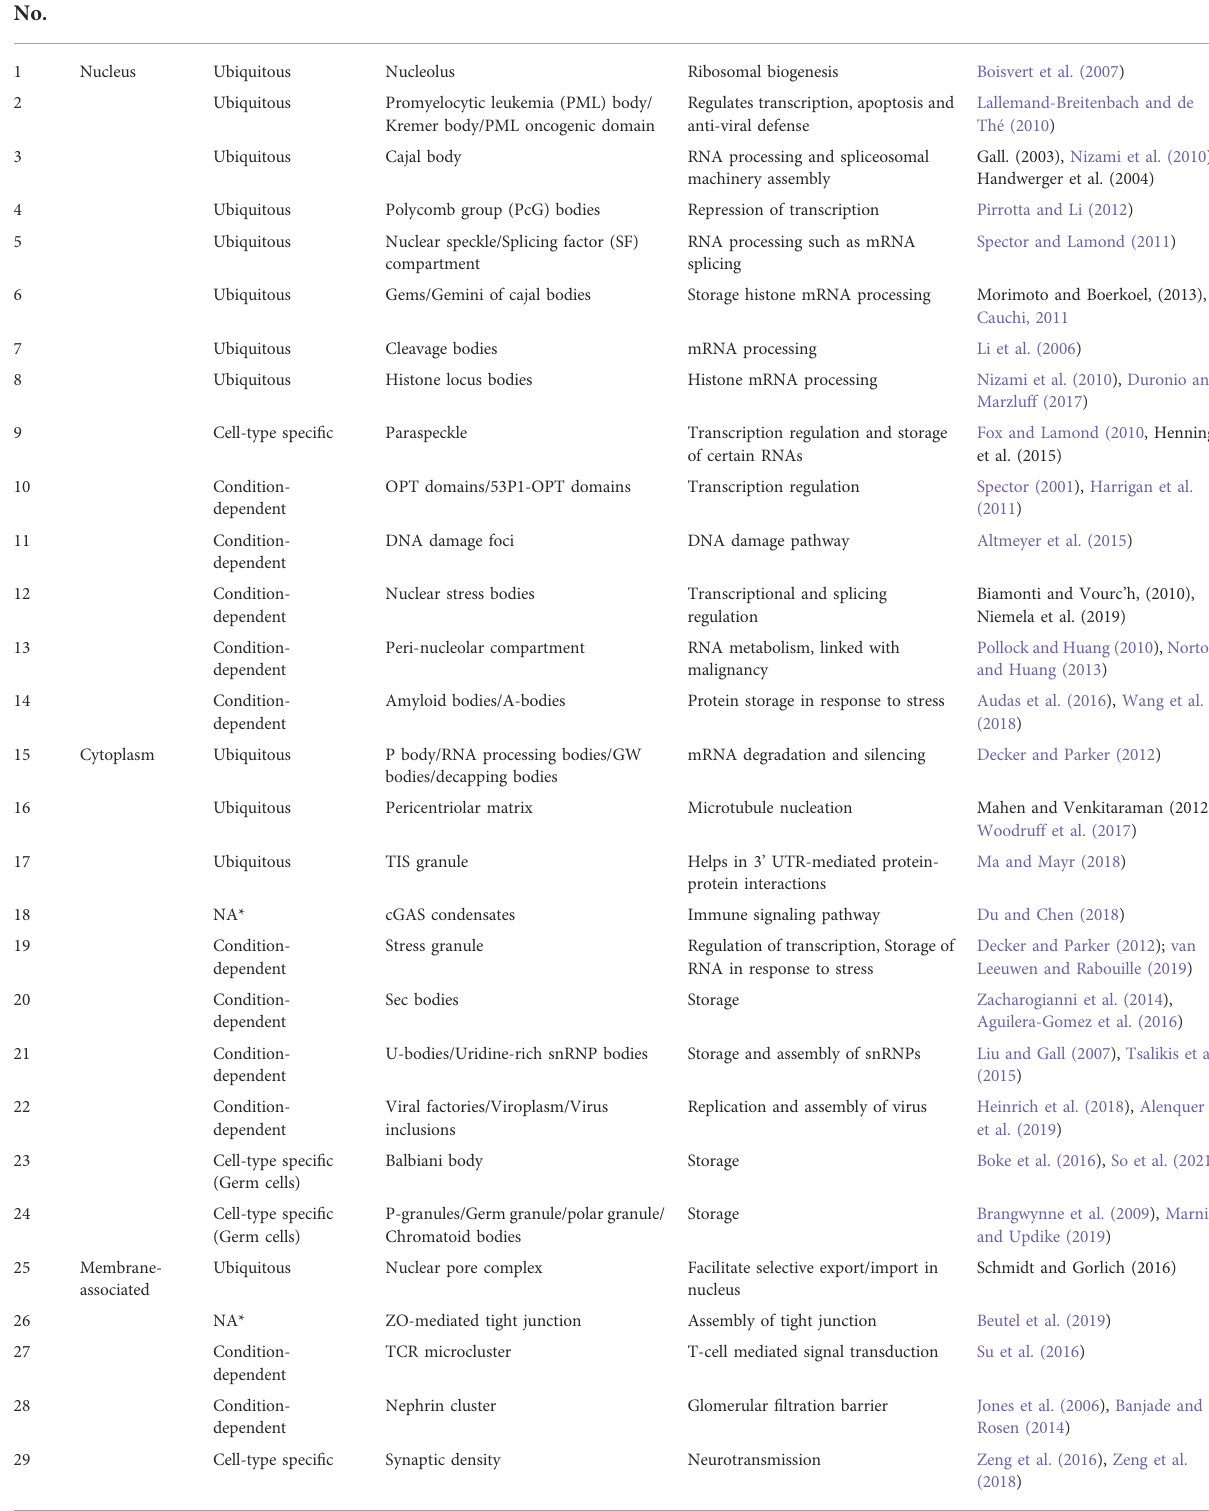
TABLE 1 List of known phase